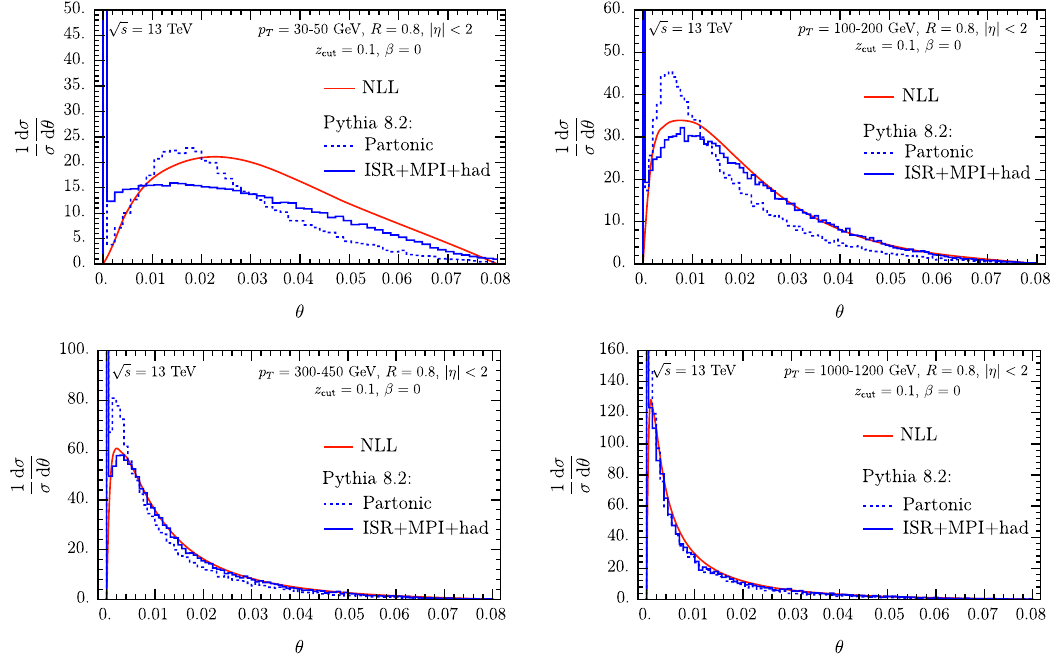
Figure 12 . Numerical results for the angle (cid:18) between the standard and the soft drop groomed jet axis with z cut = 0 : 1 and (cid:12) = 0 at NLL accuracy. We consider the same LHC kinematics as in (cid:12)gure 7 and compare to the corresponding Pythia 8.2 results.